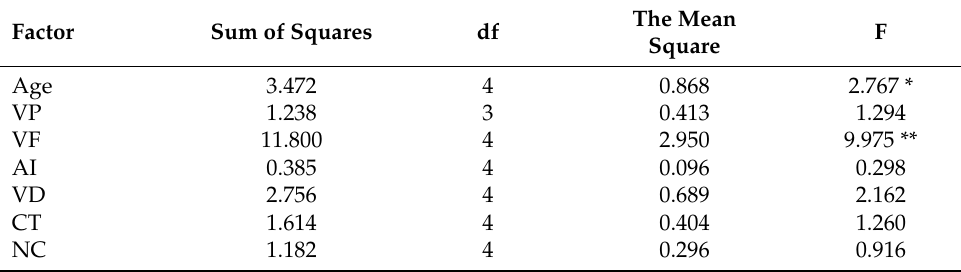
Table 9. The results of ANOVA with age and visiting characteristics as independent variables and the stress restoration index as dependent variable.